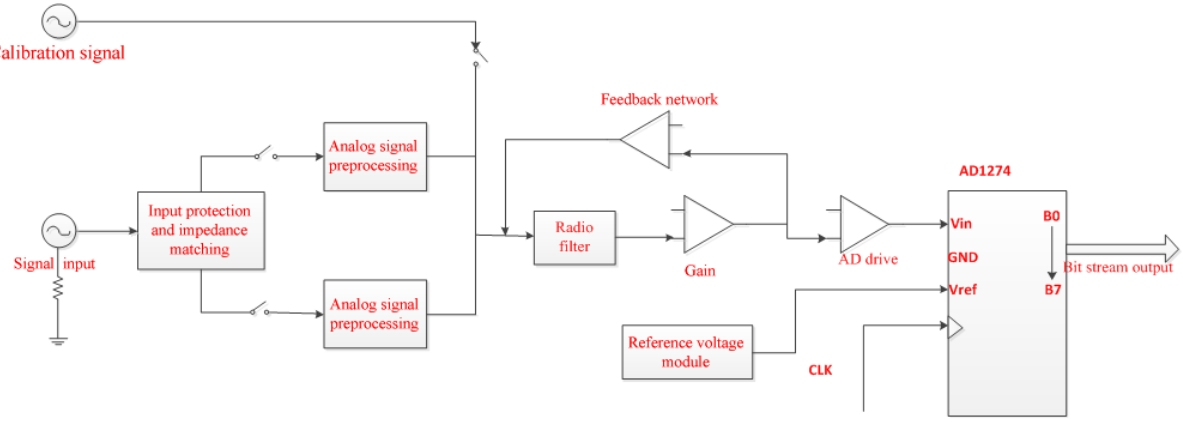
Figure 2. Operational block diagram of the single channel of the acquisition board.